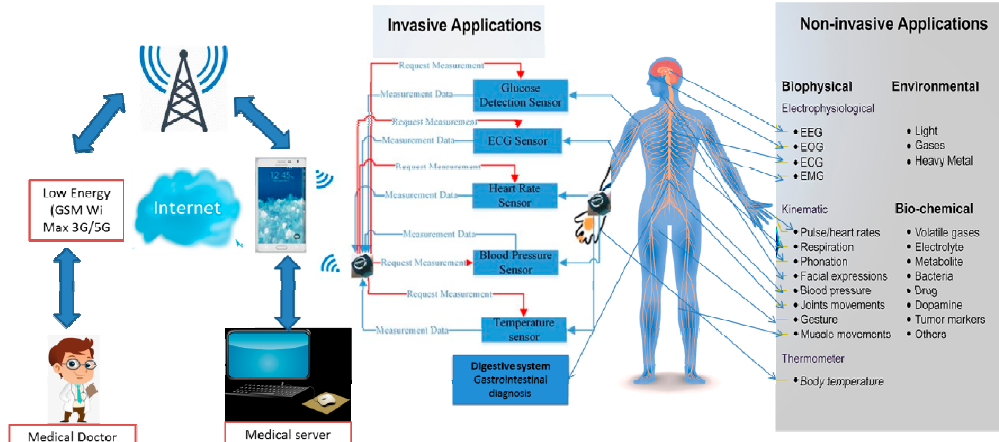
Figure 7. Unobtrusive biosensor impact classification and health monitoring system. (Point-of-care(POC) diagnostics play an essential role in delivering health care, particularly for clinical management in different organ and surveillance). Brief sensor platform for health monitoring. A significant distinction can be made between noninvasive and invasive applications, including wearable sensors for monitoring biophysical, biochemical, environmental signals, and implantable devices for nervous, cardiovascular, digestive, locomotors system.